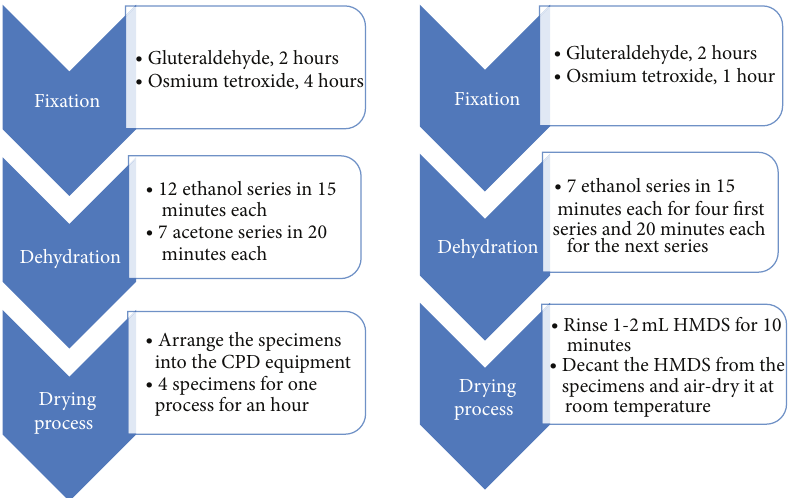
Figure 2: Comparison of sample preparation techniques based on CPD equipment and chemical